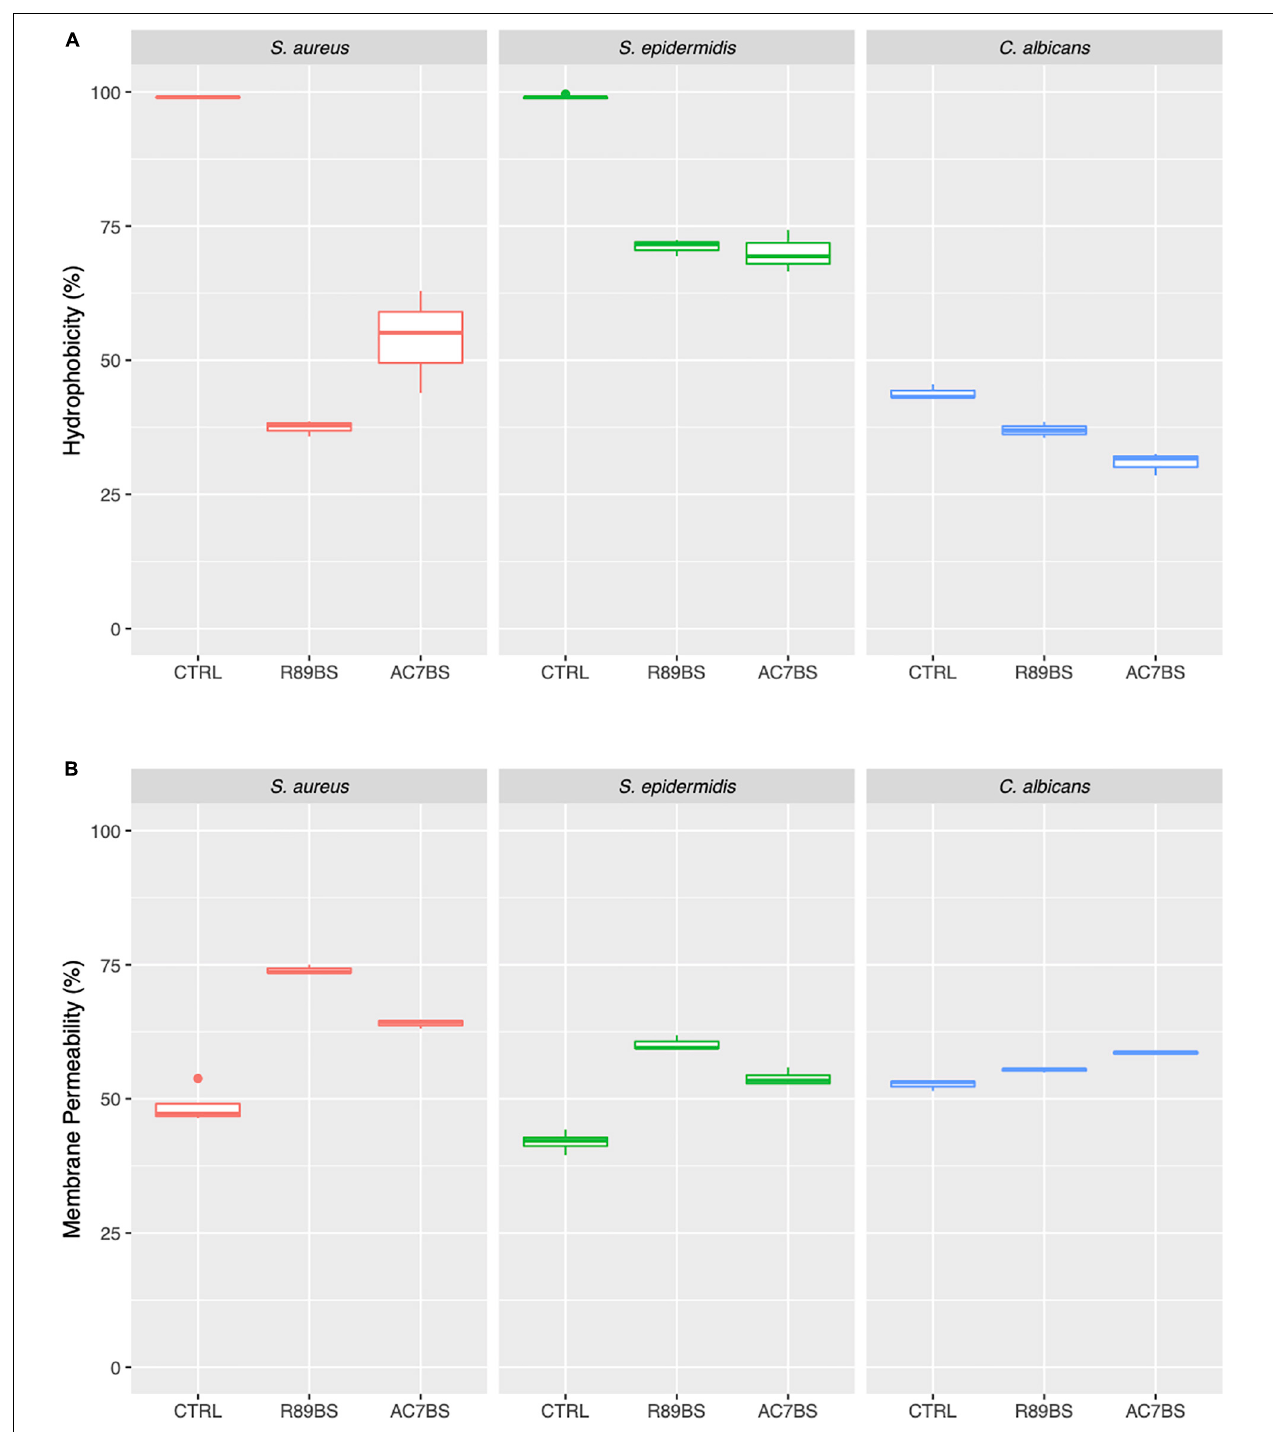
FIGURE 7 | Changes in cell surface hydrophobicity and membrane permeability induced by soluble BSs. Cell surface hydrophobicity (A) and membrane permeability (B) of C. albicans , S. aureus , and S. epidermidis treated with BSs in soluble form (co-incubation conditions), compared to control samples.